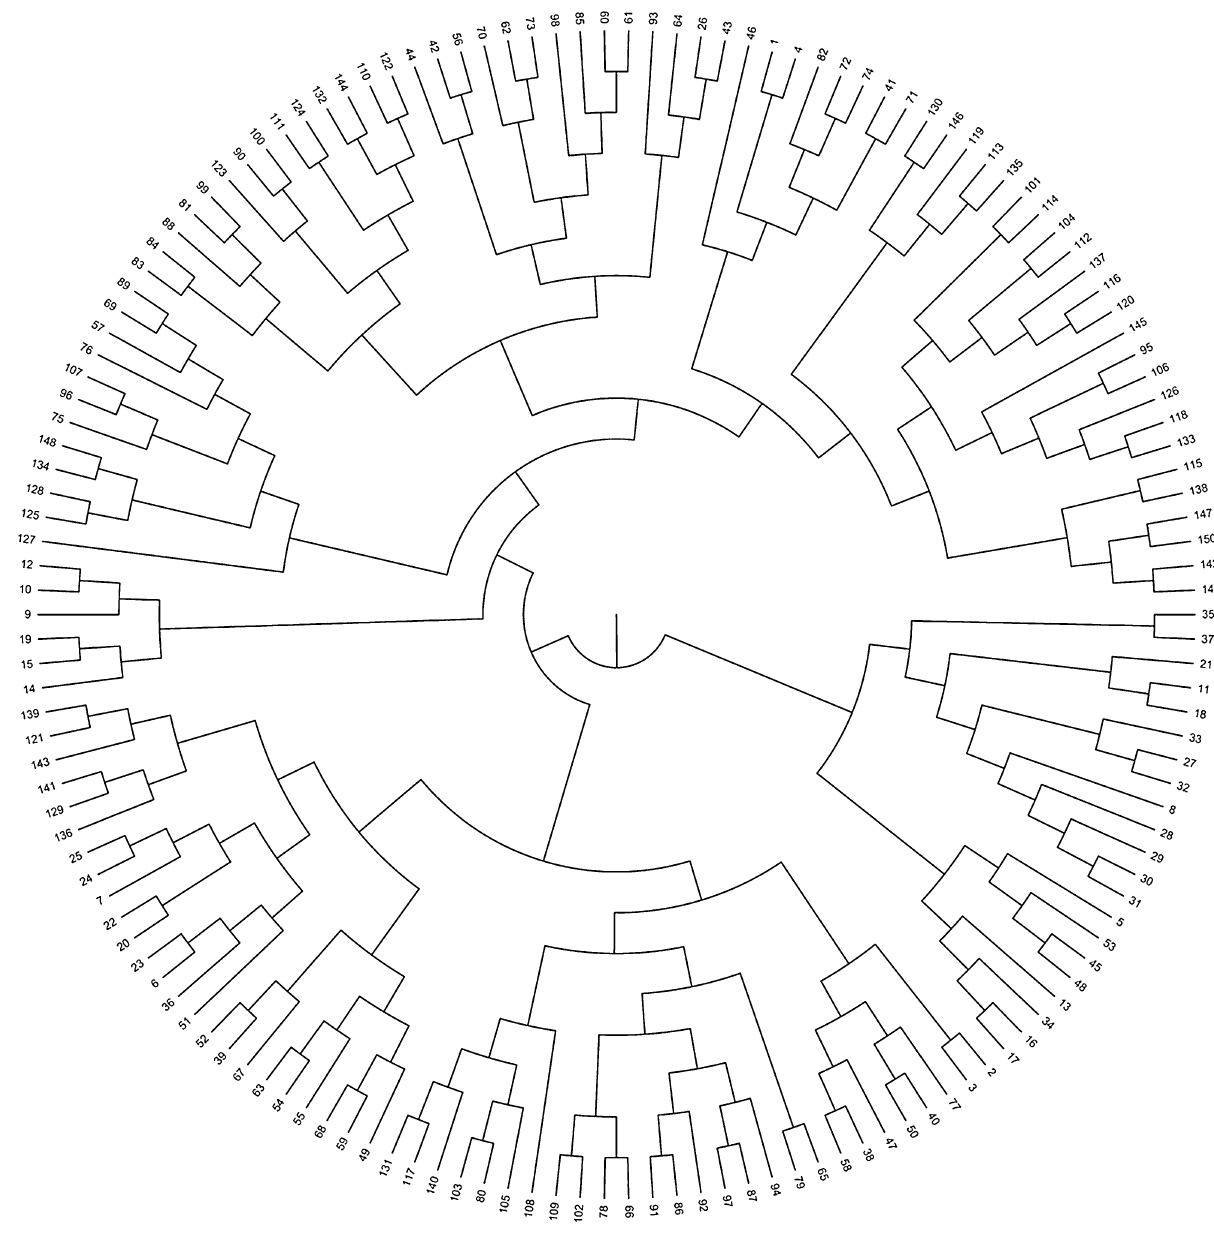
Figure 3. Systematic clustering of wheat DH